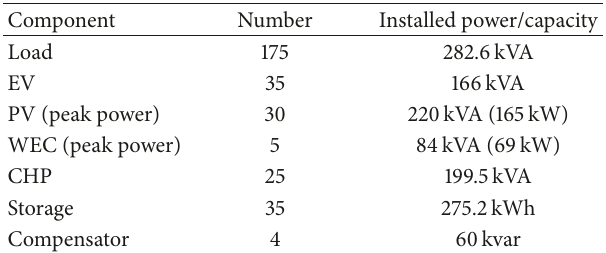
Table1:Installedpowerinscenarioof177nodes;tableadaptedfrom